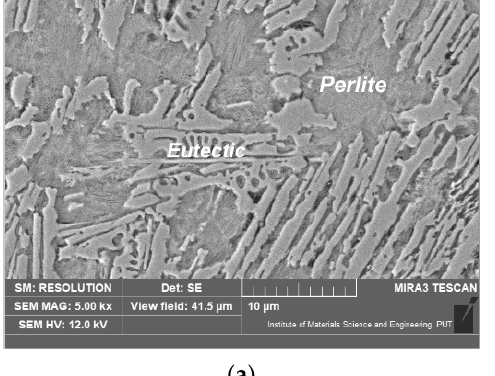
Figure 12. Microstructure of nodular cast iron surface layer, after laser alloying with silicon (scan- ning electron microscope, etched with nital 3%).